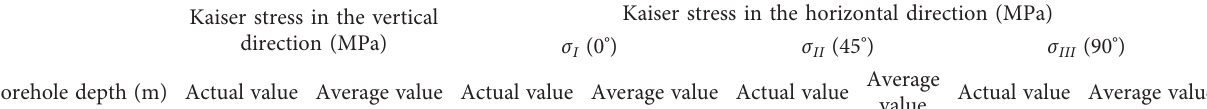
Table 1: Kaiser stress of AE tests.